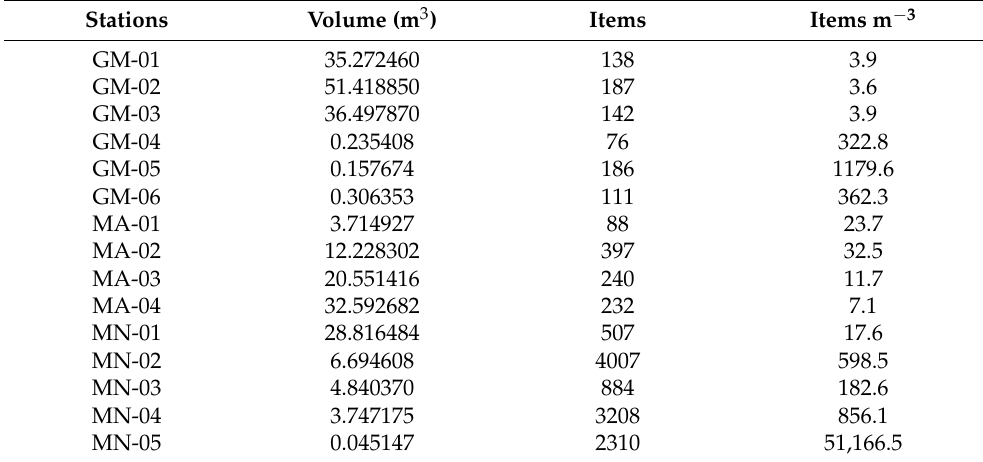
Table 4. Quantity of microplastics identified per m 3